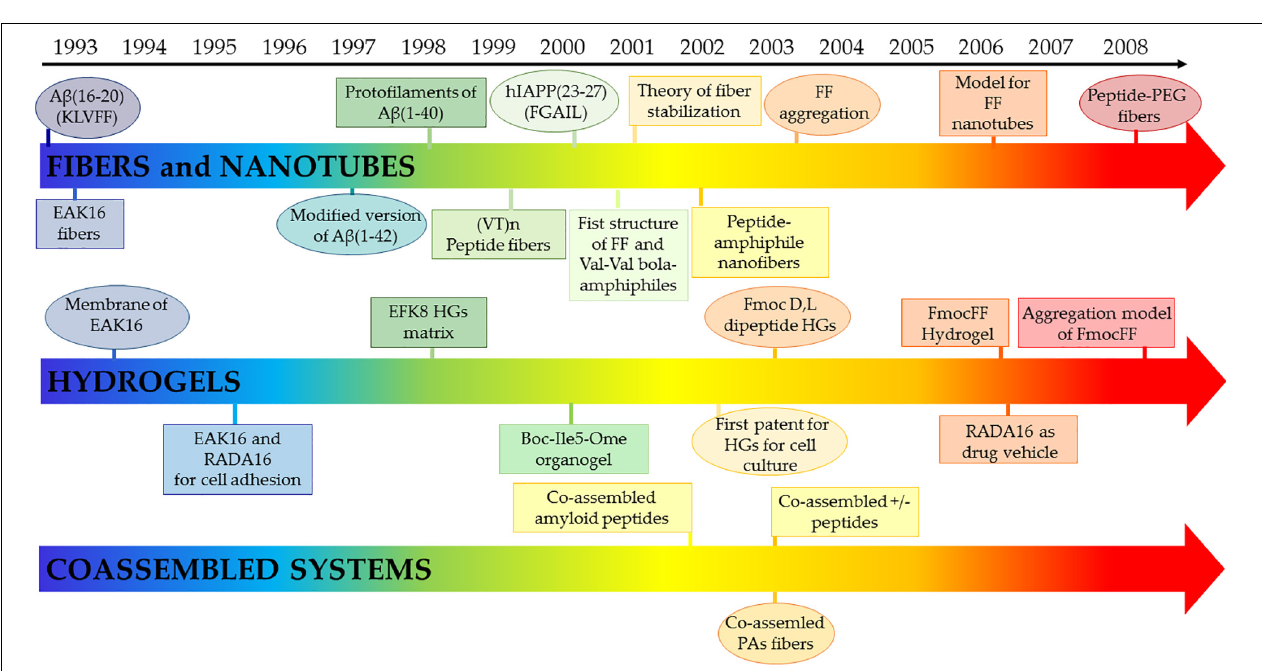
FIGURE 6 | Ball and stick representation of the SYSGYS peptide (PDB code 6bwz) from the low-complexity domain of FUS (A) . The structure of the GNNQQNY peptide (PDB code 1yjp) is also reported (B) .